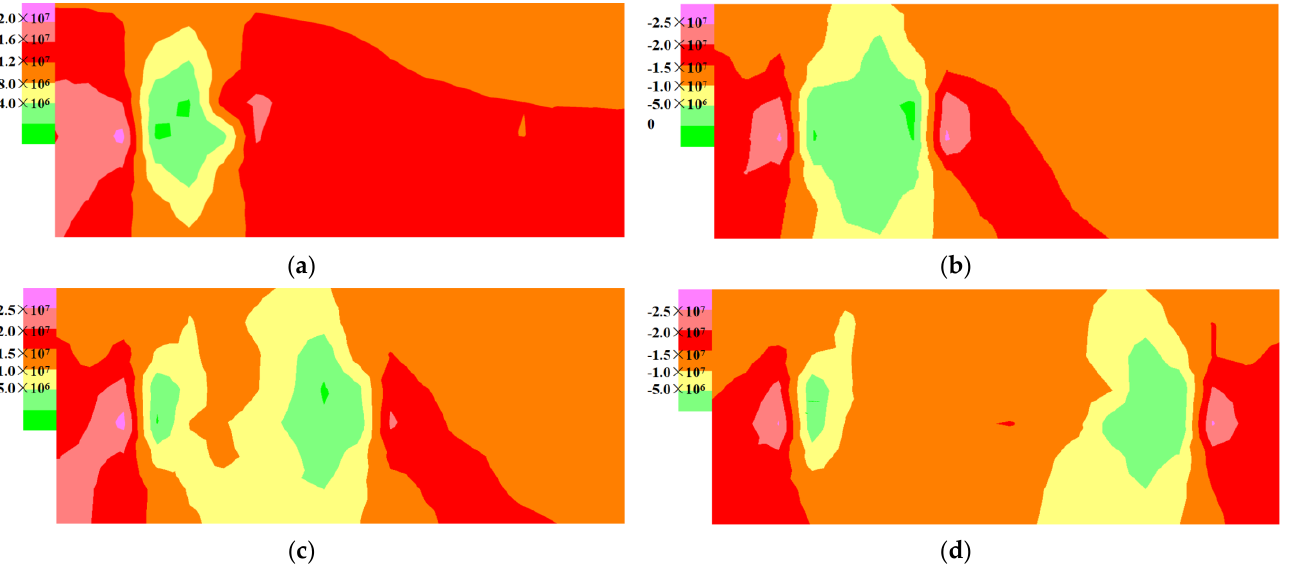
Figure 10. Vertical stress diagram of working face advancement at different distances.